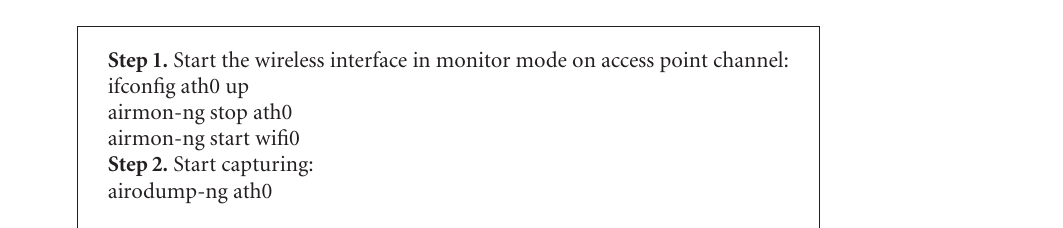
Algorithm 1: Steps to conduct tra ffi c analyzing attack.